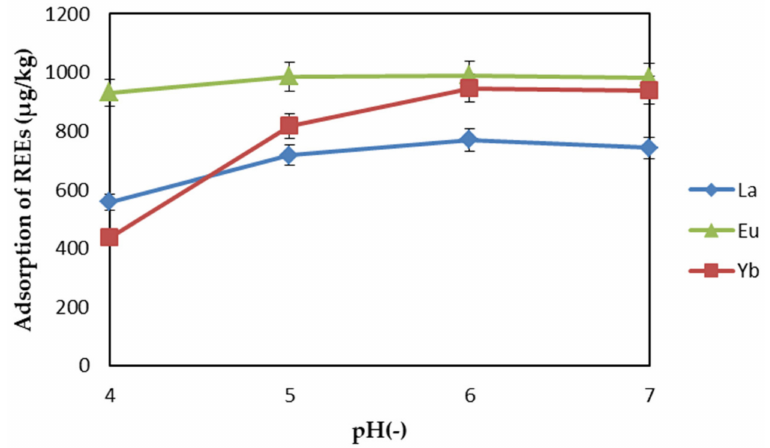
Figure 6. Effect of pH on REEs adsorption by